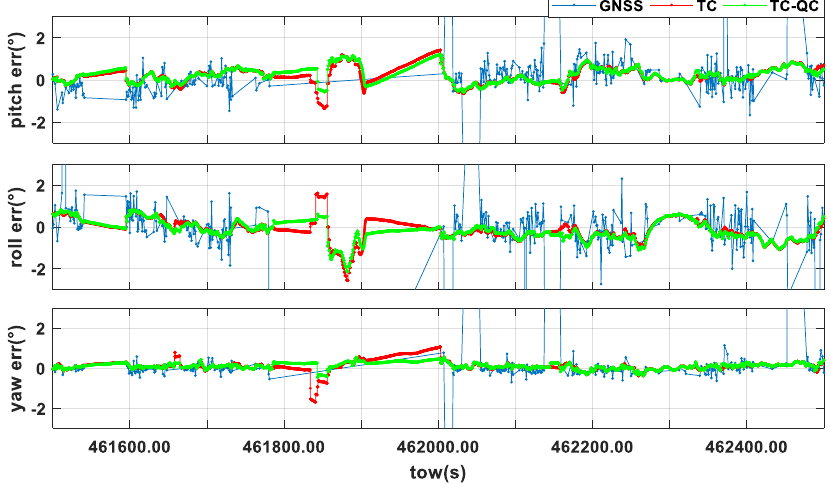
Figure 10. Time sequence of attitude